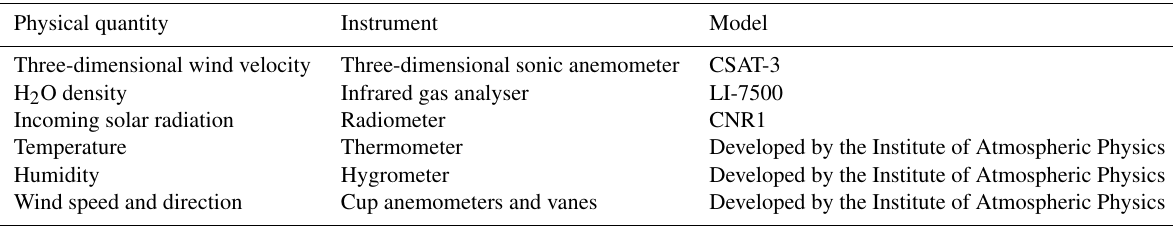
Table 2. Instruments used on the 325m IAP tower (47m level; Liu et al., 2012).